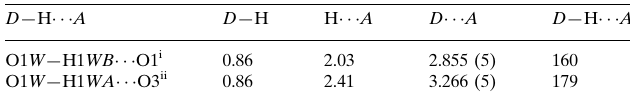
Hydrogen-bond geometry (A˚ , (cid:3)